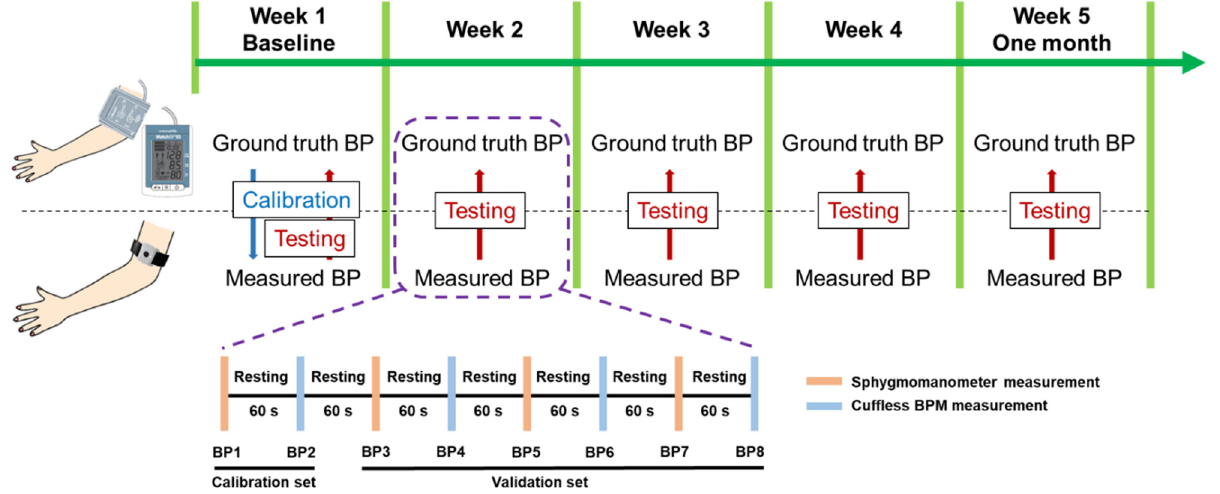
Figure 4. The measurement sequences for validating the upper-arm, cuffless PPG BPM devices by following the AAMI/ESH/ISO 81060-2 protocol for the validation of cuff-based BP measurement devices. These sequences began with baseline measurements using the reference method and the test device, followed by the validation set. An initial calibration to the reference method was a prerequisite to validating the upper-arm, cuffless PPG BPM. After the first calibration, additional validations were performed at different time points over 1 month (week by week) for a single calibration.